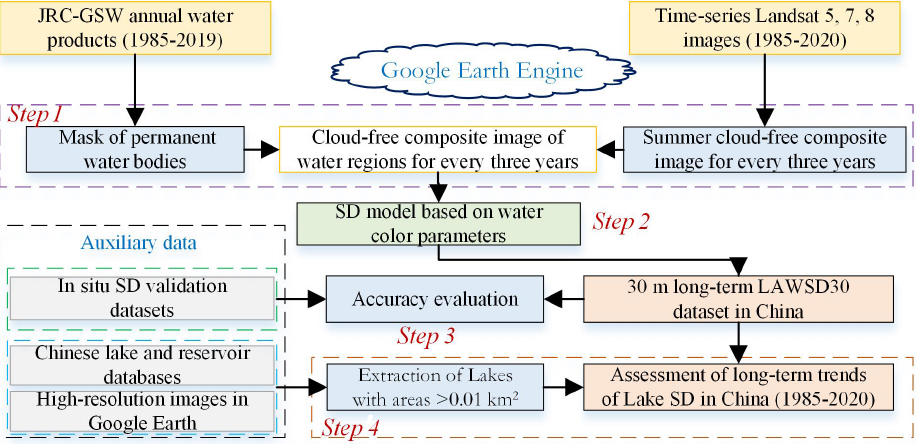
Figure 3. A flowchart of the long-term LAWSD30 dataset development steps and the long-term SD trend assessment of lakes in China. Note: LAWSD30 – 30m LAke Water SD dataset of